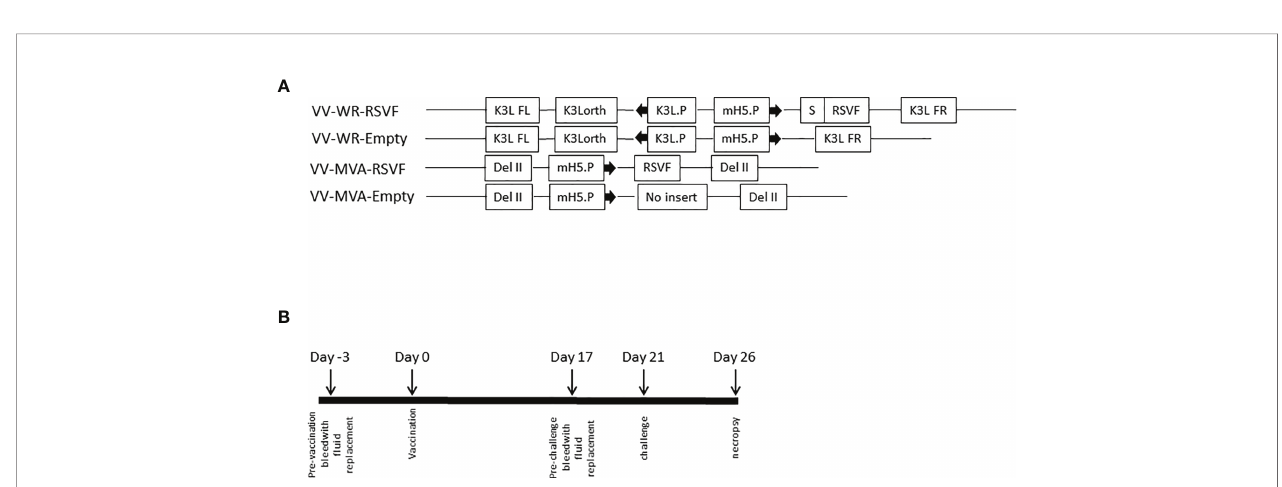
FIGURE 3 | Vaccinia vectored constructs and vaccination regimen. (A) Schematic representation of the WR and MVA vaccinia virus constructs. Both VV-WR-RSVF and VV-MVA-RSVF express the full length RSV F protein. The VV-WR-RSVF F protein transgene is preceded by a secretion signal, S and is under the control of the mH5 promoter, mH5.P. This sequence is fl anked by the K3L ortholog regions. The VV-MVA-RSVF contains the RSV F gene under the control of mH5.P promoter inserted by homologous recombination in the del II region of VACV genome, as described by Wyatt et al. (26). VV-WR-Empty and VV-MVA-Empty do not encode for RSV F (B) Schematic diagram of the immunization, RSV challenge and necropsy